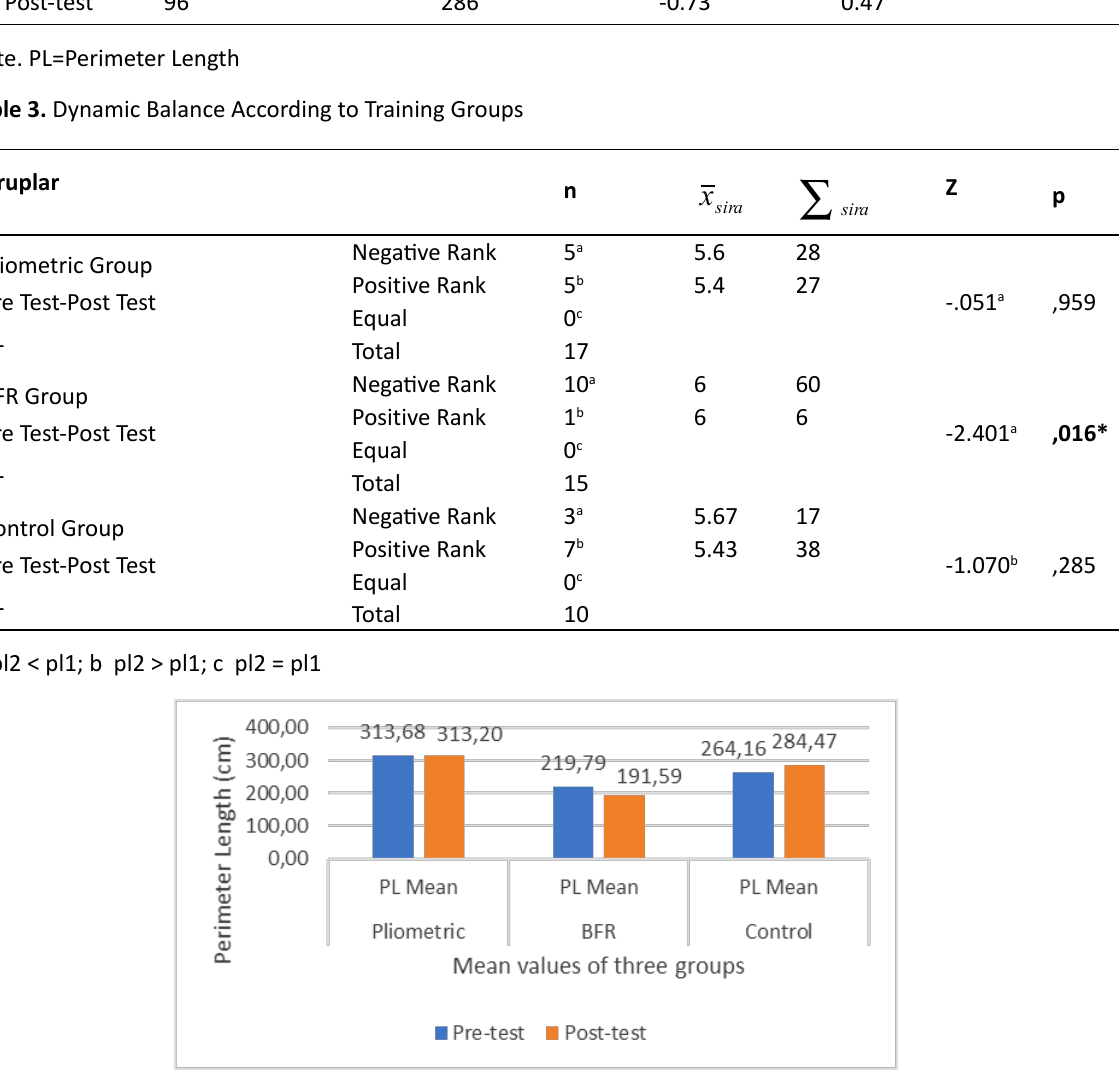
Figure 3. Pre-test Post-test Perimeter Length